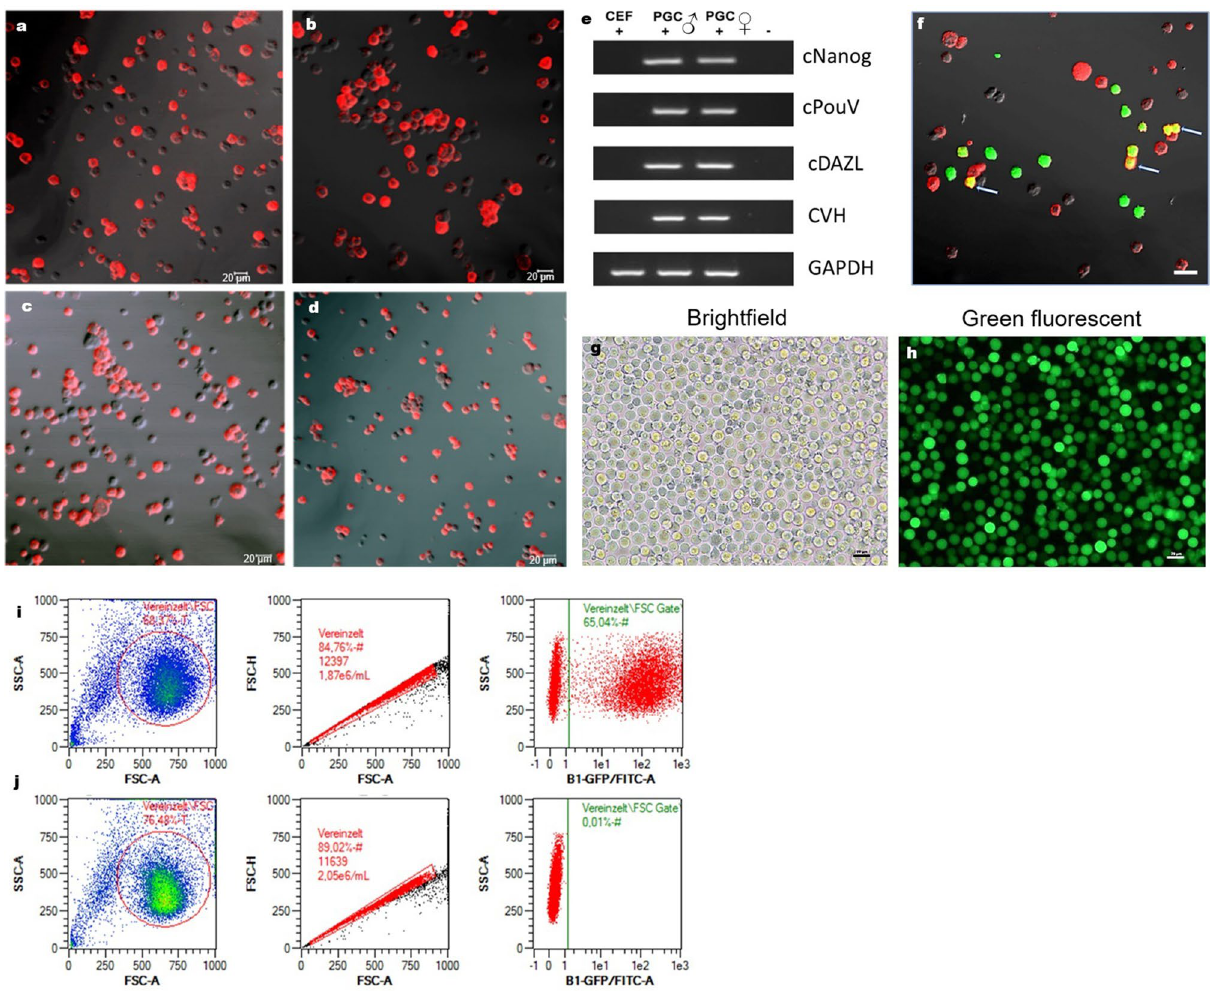
Figure 2. Characterization of Venus-positive PGCs. ( a – d ) Immunofluorescence of SSEA-1 on the surface of PGCs (scale bar = 20 µm). ( a ) male PGC cell line (homozygous blue-allele). ( b ) female PGC cell line (homozygous blue-allele). ( c ) male PGC cell line (heterozygous blue-allele). ( d ) male PGC cell line (nullizygous blue-allele). ( e ) Expression of marker genes in male and female PGCs, CEF: chicken embryo fibroblasts, pluripotency marker: cNANOG , cPOUV , stem cell marker: cDAZL , CVH , housekeeping gene: GAPDH , blank—no cDNA control. ( f ) Immunofluorescence of SSEA-1 (arrows: co-expression of SSEA-1 and Venus- protein), (scale bar: 20 µm). ( g + h ) Expression of the Venus-gene in cultured chicken PGCs, ( g ) Brightfield, ( h ) Venus + PGCs (scale bar: 25 µm). ( i + j ) Venus-fluorescence of PGCs transfected with Venus-transposon in presence and absence of transposase; ( i ) post-transfection status of PGCs transfected with Venus-transposon and SB-transposase. 65% of PGCs with transient integrated Venus-gene; ( j ) post-transfection status of PGCs transfected with Venus-transposon and without SB-transposase. No Venus-fluorescence is